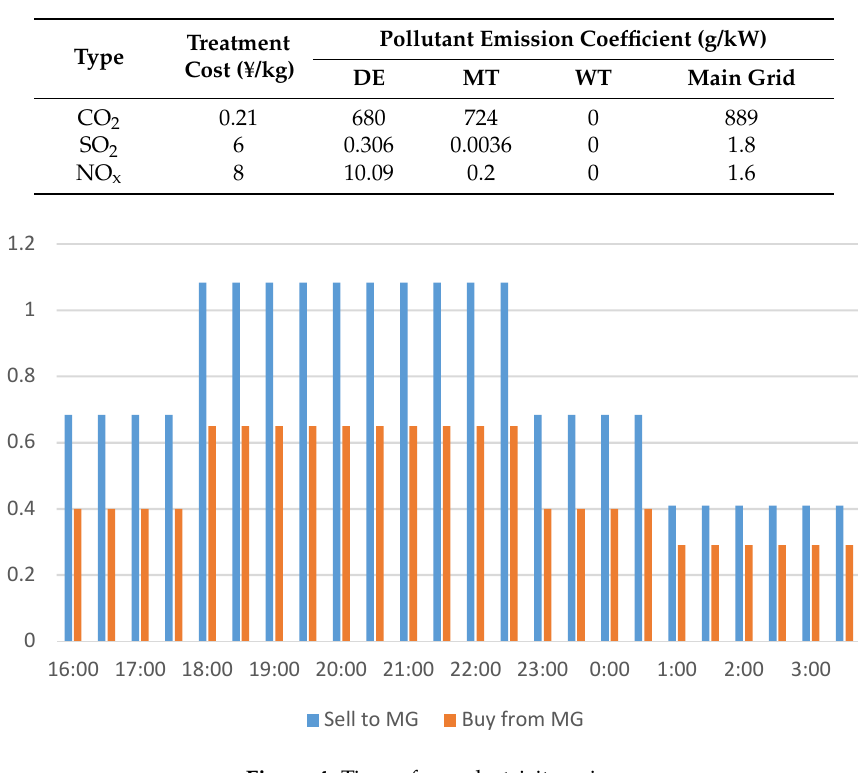
Table 3. Environmental parameters.